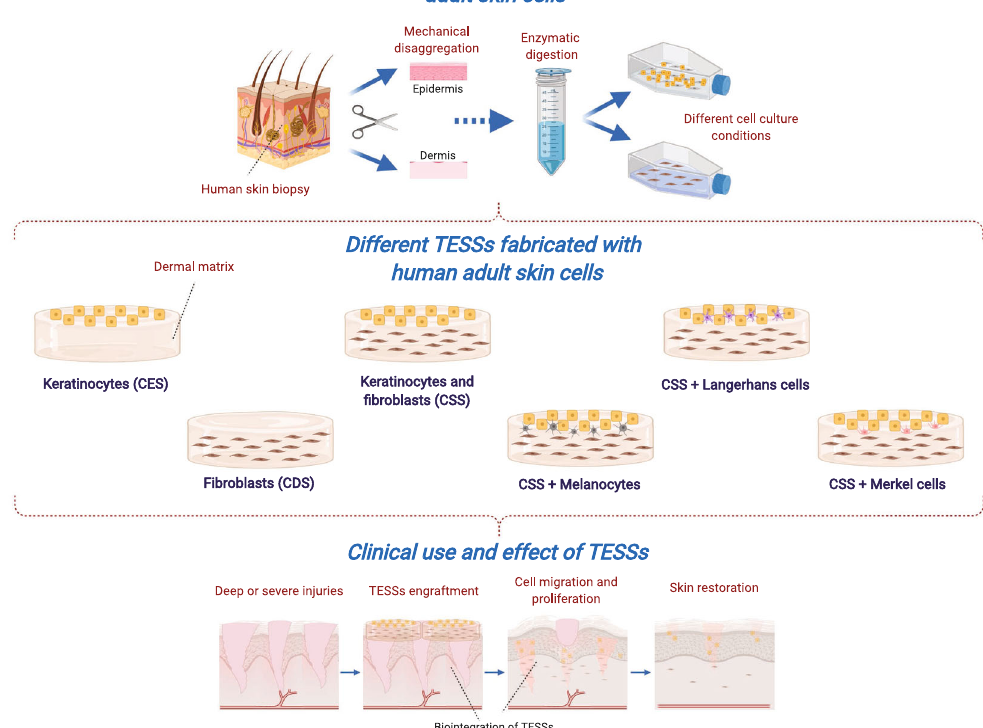
Fig. 2 Tissue-engineered skin substitutes (TESSs) fabricated with human adult skin cells and their role in wound healing process. After a deep, severe or chronic injury where, normal phases of healing are not possible, fabrication of TESSs from cells of a human skin biopsy is the most usual advanced therapy. Keratinocytes, fi broblasts and the rest of epithelial cells are isolated, expanded and used in combination with a biological matrix to produce sheets of cultured epithelial substitutes (CESs), cultured dermal substitutes (CDSs) and composite skin substitutes (CSSs), which are engrafted to promote and facilitate cell activation and the release of growth factors necessary to achieve reparation, regeneration and homeostasis of skin. Created with